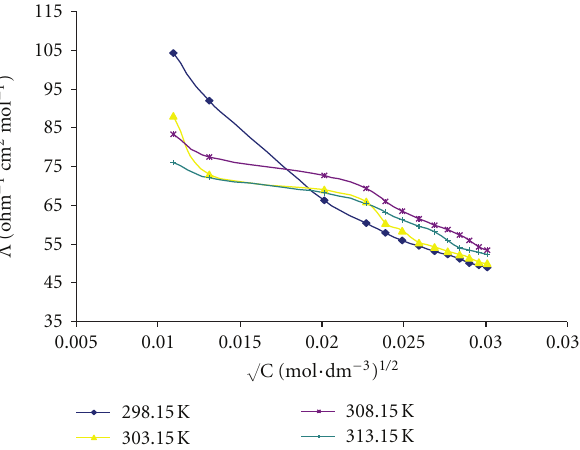
F 3: Molar conductance versus square root of concentration for Cu-succinate at different temperatures.